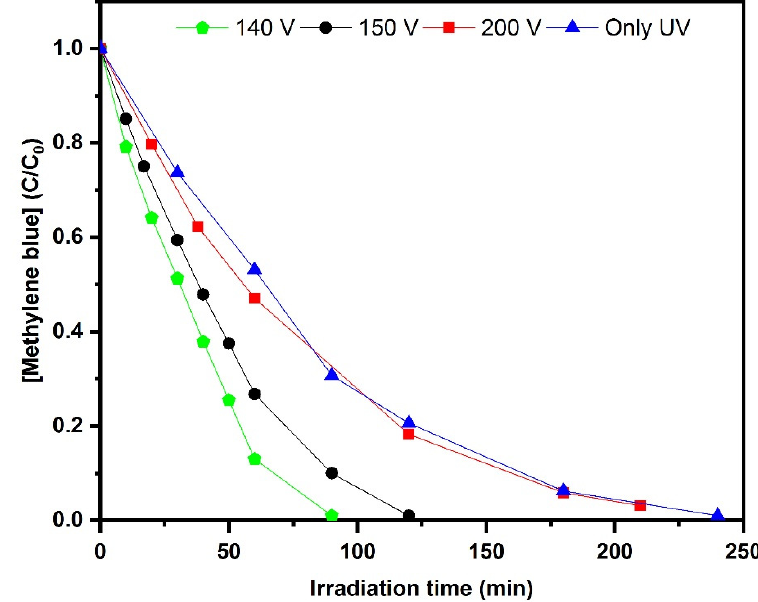
Figure 9. Degradation of methylene blue (C / C 0 ) as a function of irradiation time.